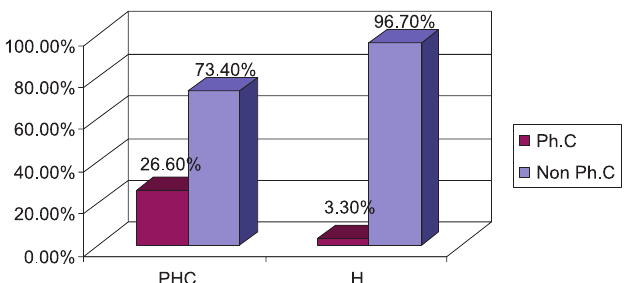
FIGURE 1 - Professionals’ participation in pharmaceutical care programs. p =